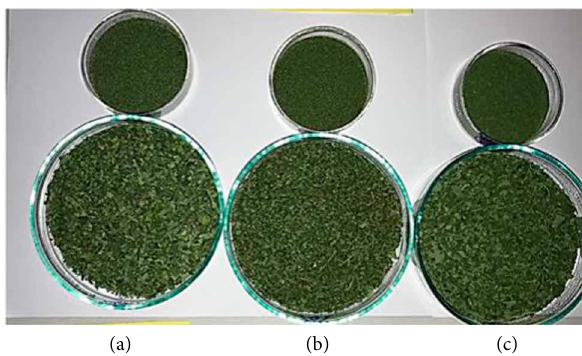
Figure 1: Unblanched Moringa leaves dried at (a) 55°C, (b) 60°C, Figure 2: Steam blanched Moringa leaves dried at (a) 55°C, (b) 60°C, (c) 65°C.